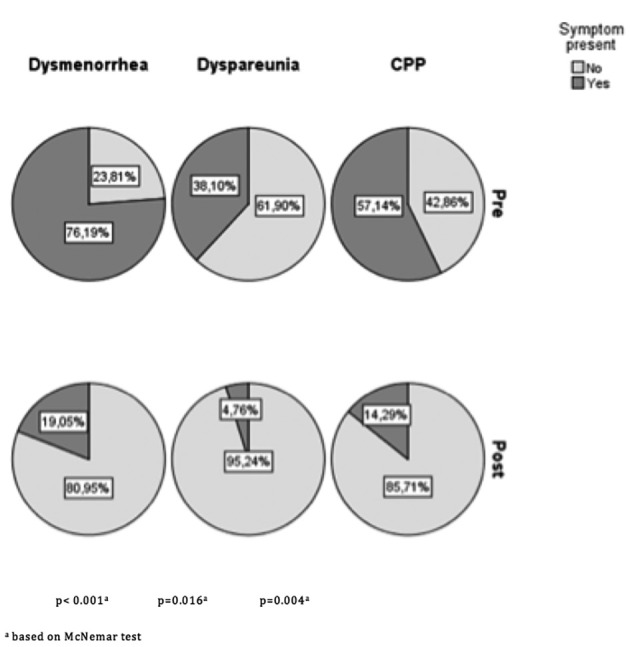
Proportions of patients with pre- and postopertive pain complaints.